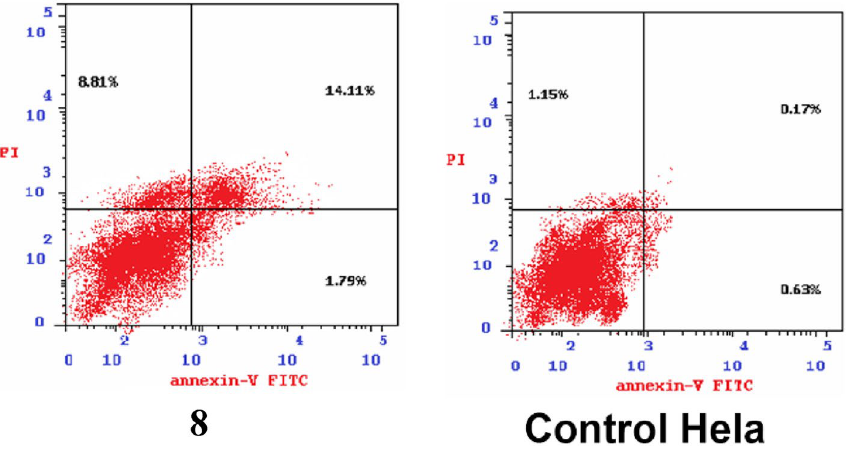
Figure 6. Apoptosis effect on MCF-7 and Hela cell lines induced by compound 8 .